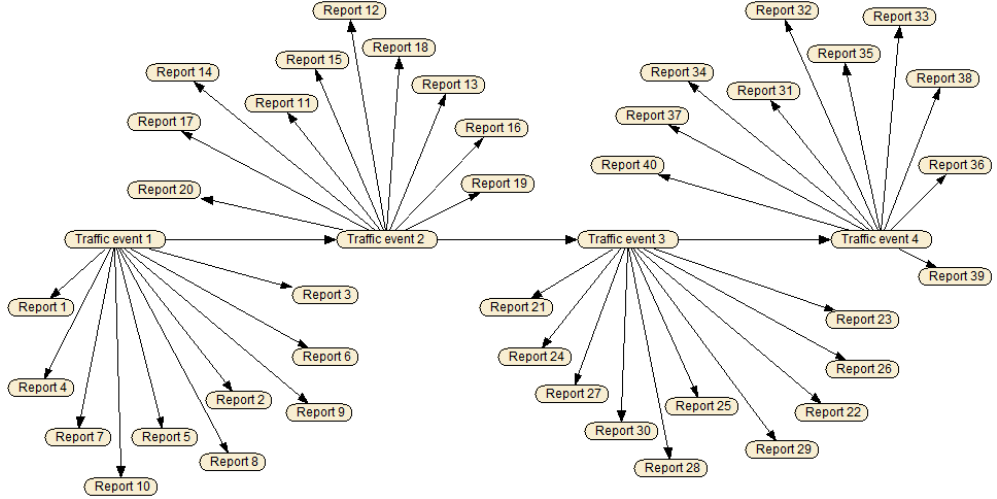
Figure 11. Screenshot of Bayesian network for